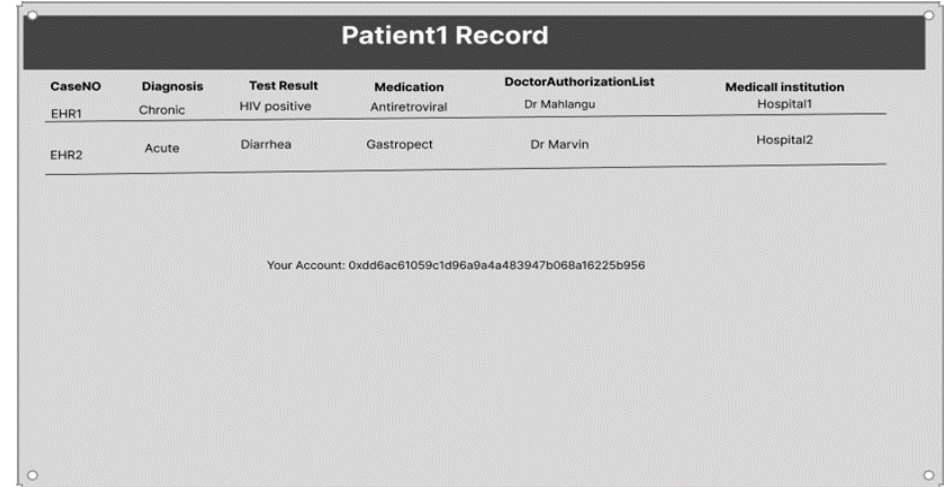
Figure 11. History of patient medical records.